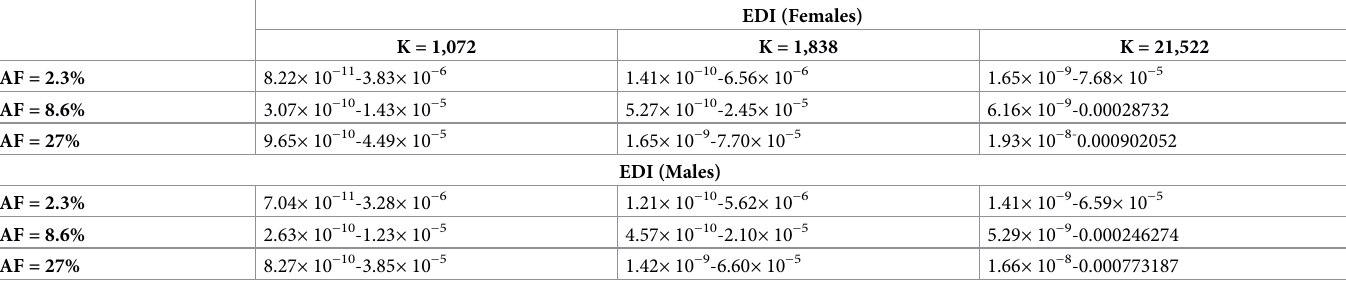
Table 6. EDI ( μ g/kg bw/day) range for general population (females and males) from “others” thermal paper receipts under varying AF and k values.